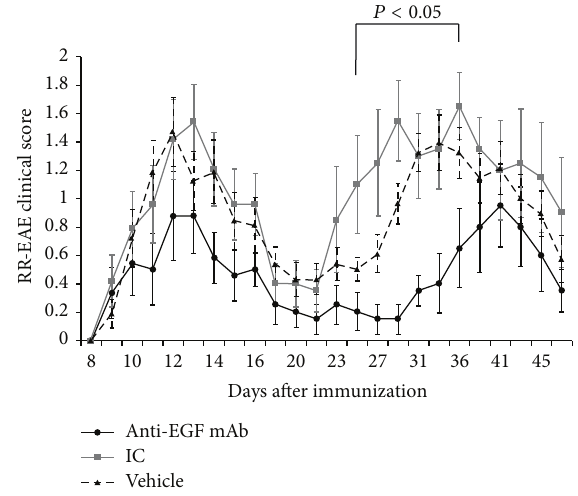
Figure 1: Treatment with anti-EGF Ab ameliorated EAE severity and delayed the onset of the second relapse. Relapsing experimental autoimmune encephalomyelitis (EAE) was induced in 36 SJL female peptide on mice that were subcutaneously injected with PLP 139 - 151 day 0 in Freund’s adjuvant and were injected intraperitoneally with 300 ng pertussis toxin on day 0 and 48 hours after induction of EAE. The mice were divided in 3 groups ( 𝑛 = 12 each). On day 9 after induction, the mice were intravenously injected with either 60 𝜇 g/mouse anti-human EGF Ab or PBS alone (the vehicle) or with 60 𝜇 g/mouse normal goat IgG and they served as controls ( 𝑛 = 12 in each group). A therapy with anti-EGF Ab significantly ameliorated EAE severity during the second relapse and postponed its onset, an effect that was significant between days 25 and 36 after